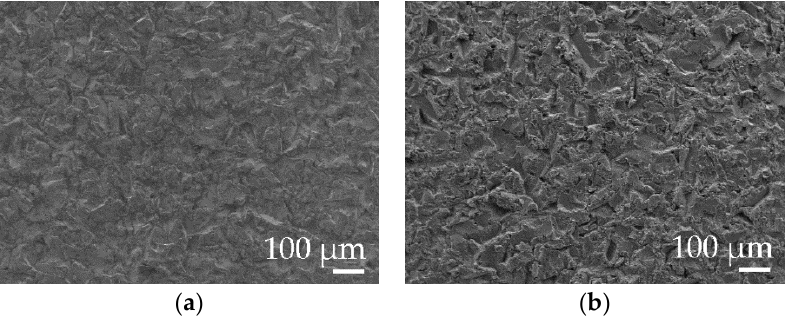
Figure 9. Micrography of the superficial appearance of the EN-AW5754 substrate after blasting with brown corundum at 0.4 MPa ( a ) with SPI laser-CW and ( b ) Quanta-Q-switch.